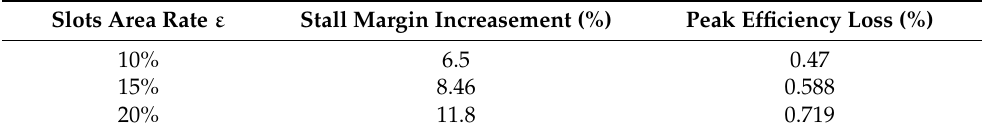
Table 3. SMI and peak efficiency loss value under the influence of different slot area ratios.